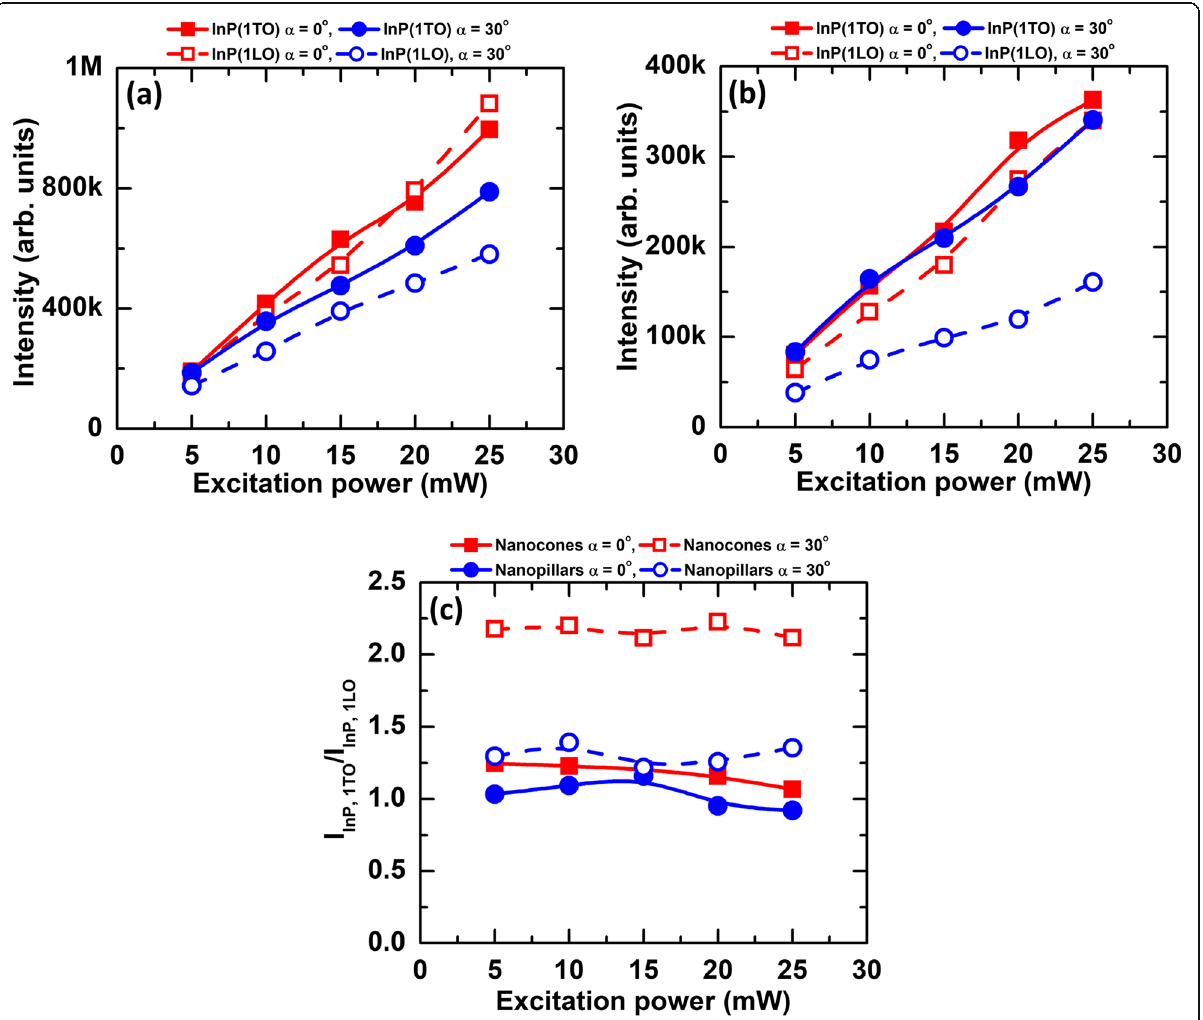
Fig. 4 An excitation power dependence on Raman spectra of InP 1TO and InP 1LO peaks for different substrate tilts. a InP/InAs/InP nanopillars. b InP/InAs/InP nanocones. c Integrated intensity ratio of InP 1TO over InP 1LO